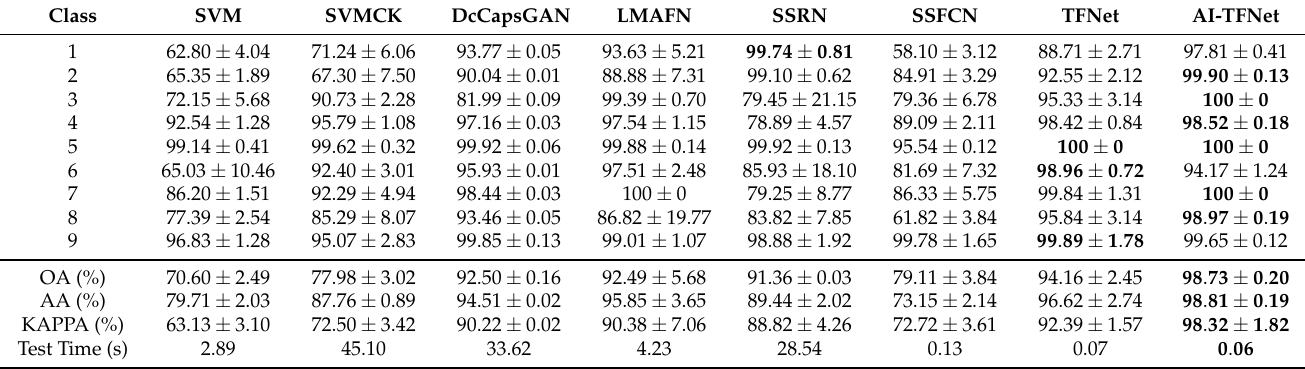
Table 8. Classification accuracy of different methods on the University of Pavia dataset with 20 labeled samples for 10 random iterations. (The best results in each row are represented in